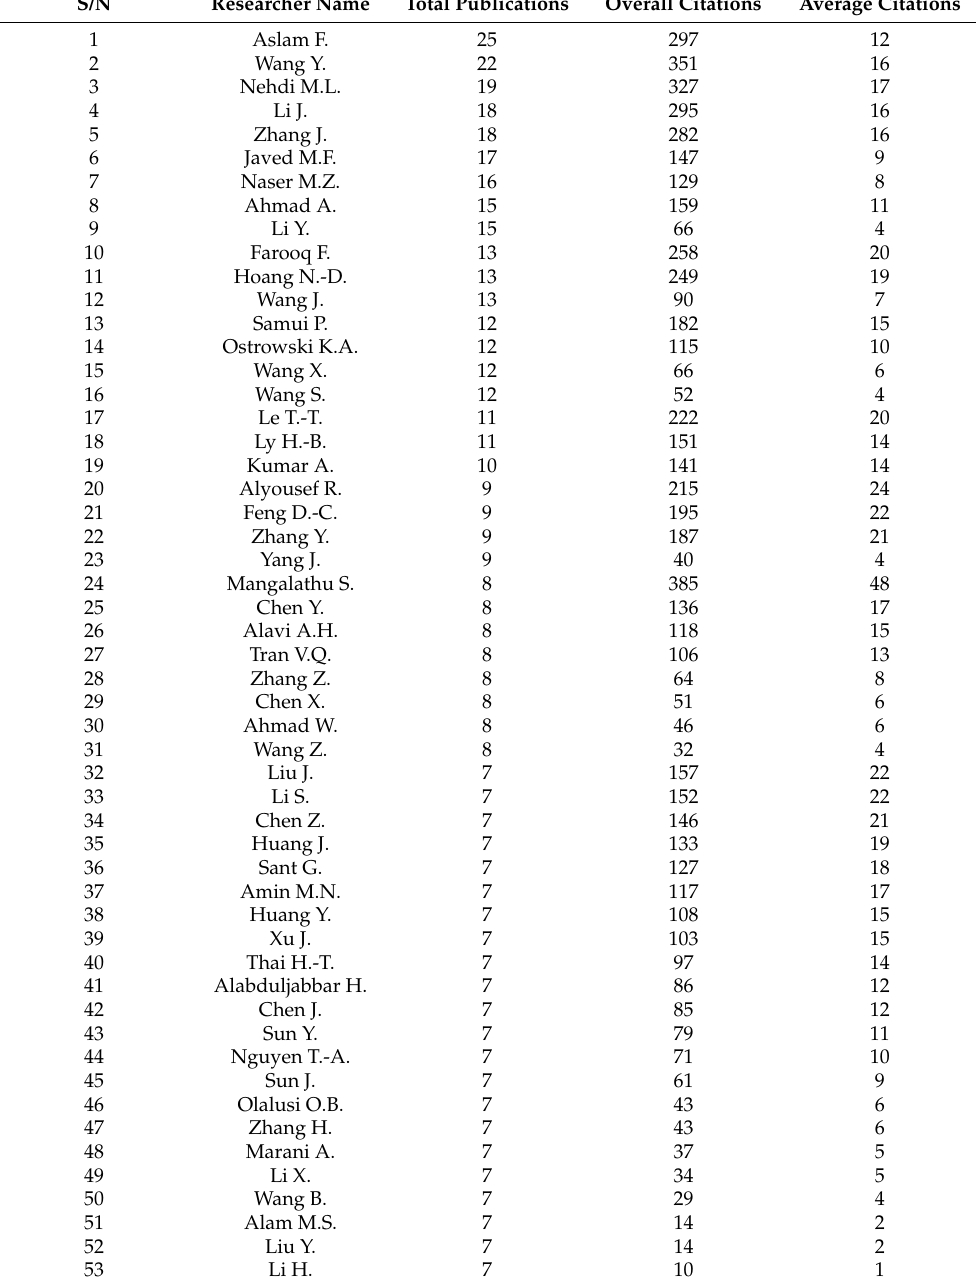
Table 3. List of researchers having at least 7 articles in the subject research domain from 2001 to May